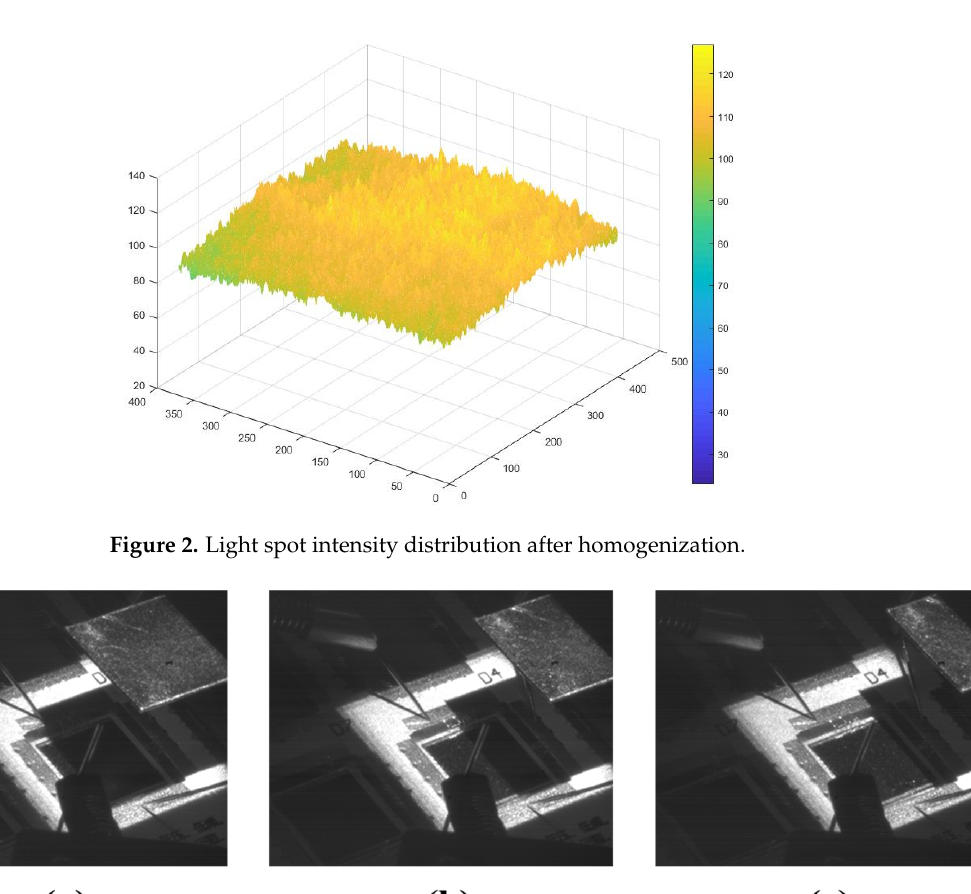
Figure 3. Test laser photovoltaics under different area irradiation percentages; ( a ) 20% irradiation; ( b ) 50% irradiation; ( c ) 90% irradiation.